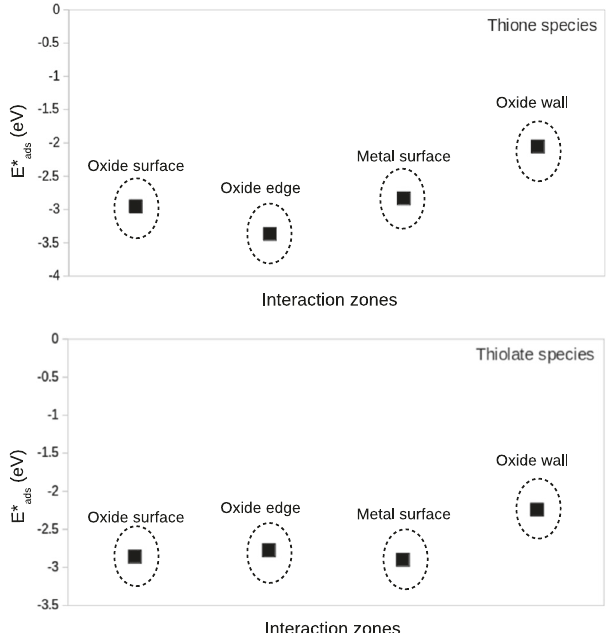
Fig. 10 Local energetic trends. Thione and thiolate species adsorbed on the different surface zones on a partially oxide- covered copper